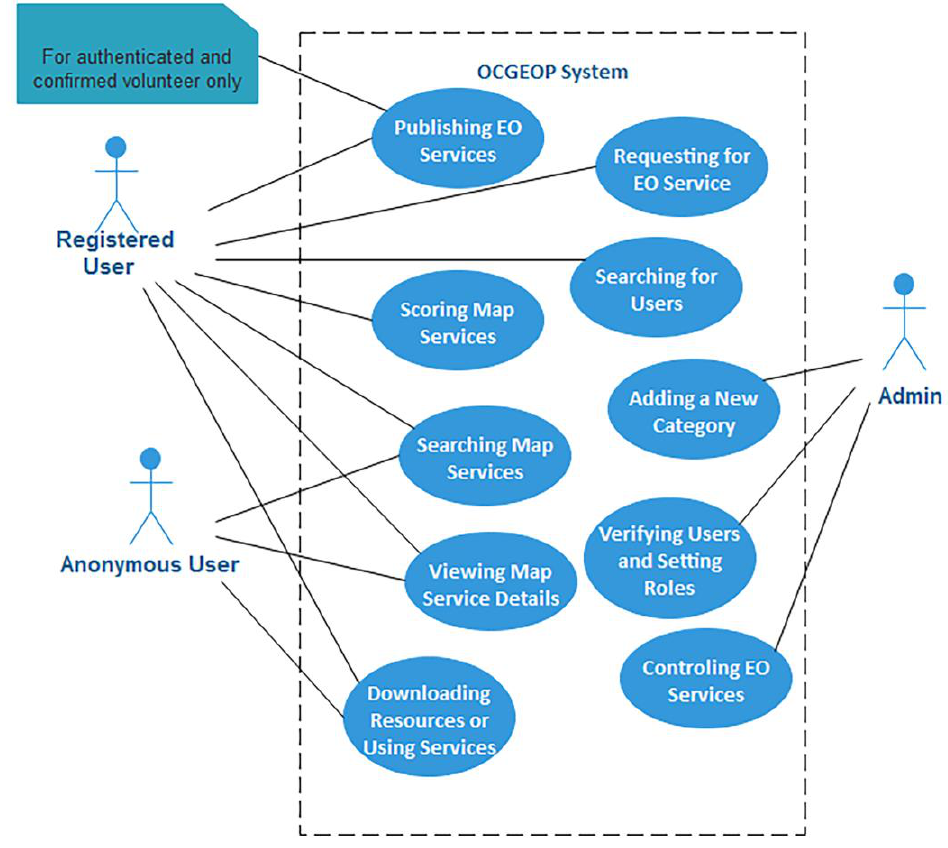
Figure 5. Important use cases and the interactions within the